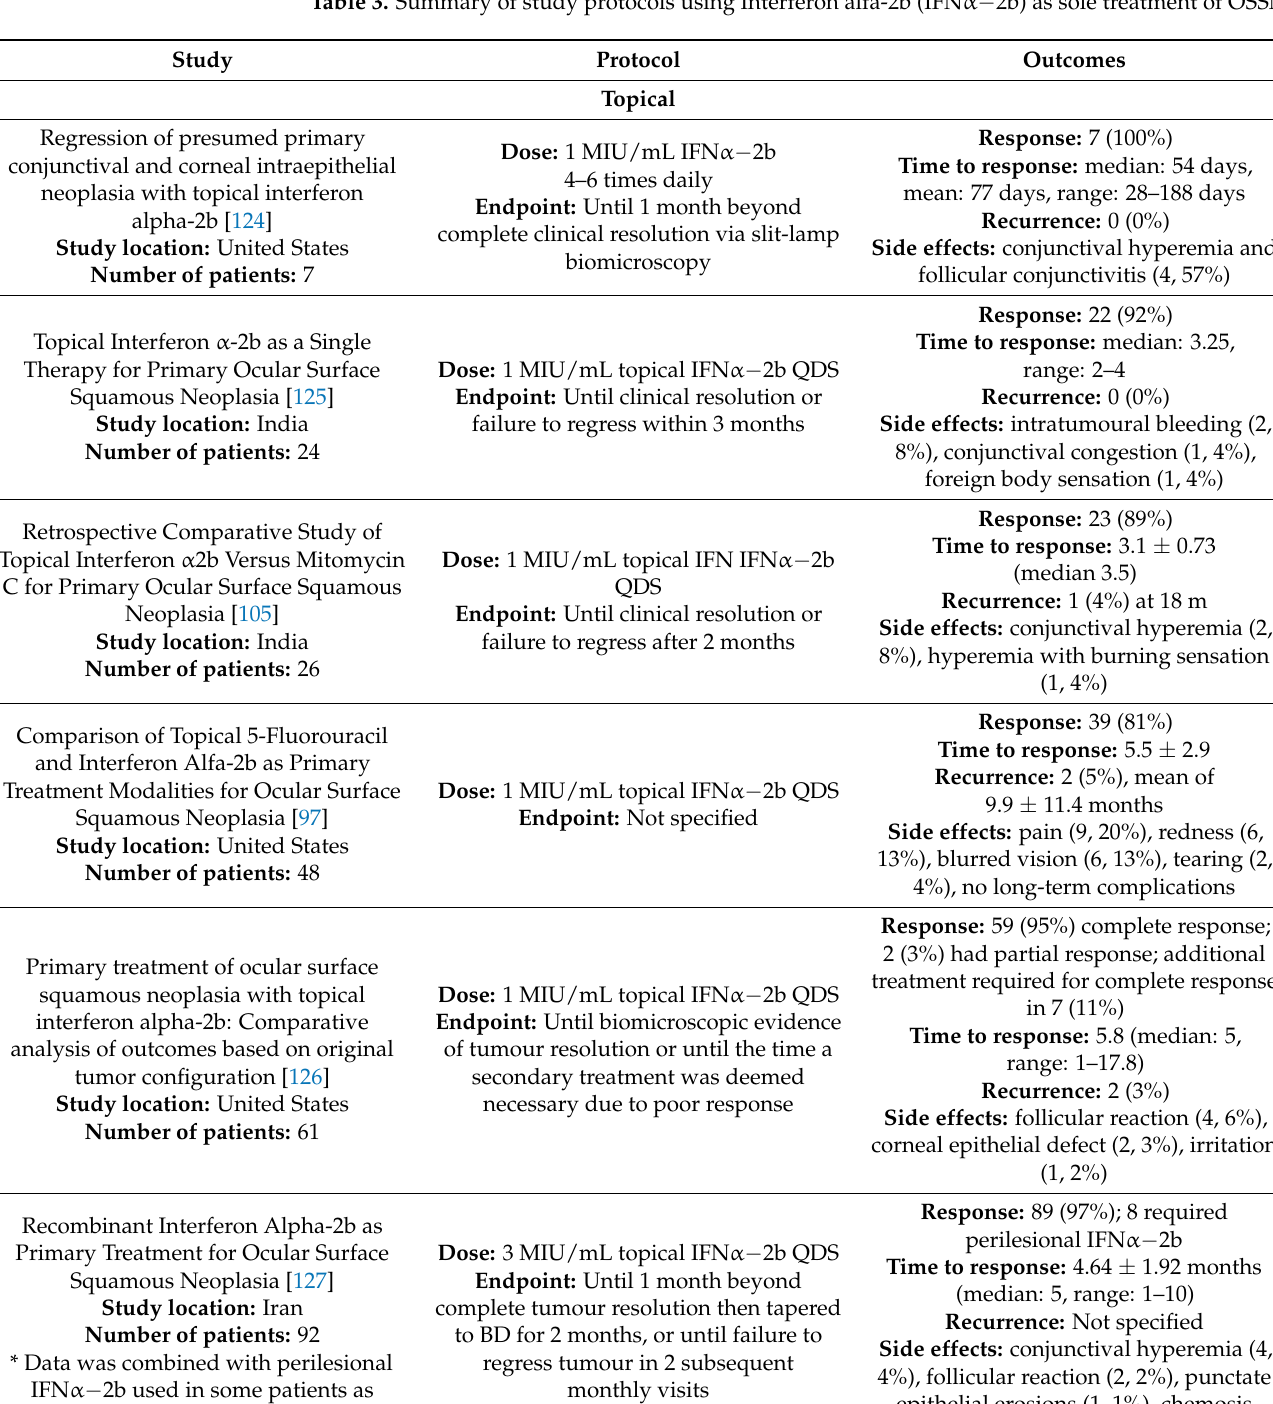
Table 3. Summary of study protocols using Interferon alfa-2b (IFN α − 2b) as sole treatment of